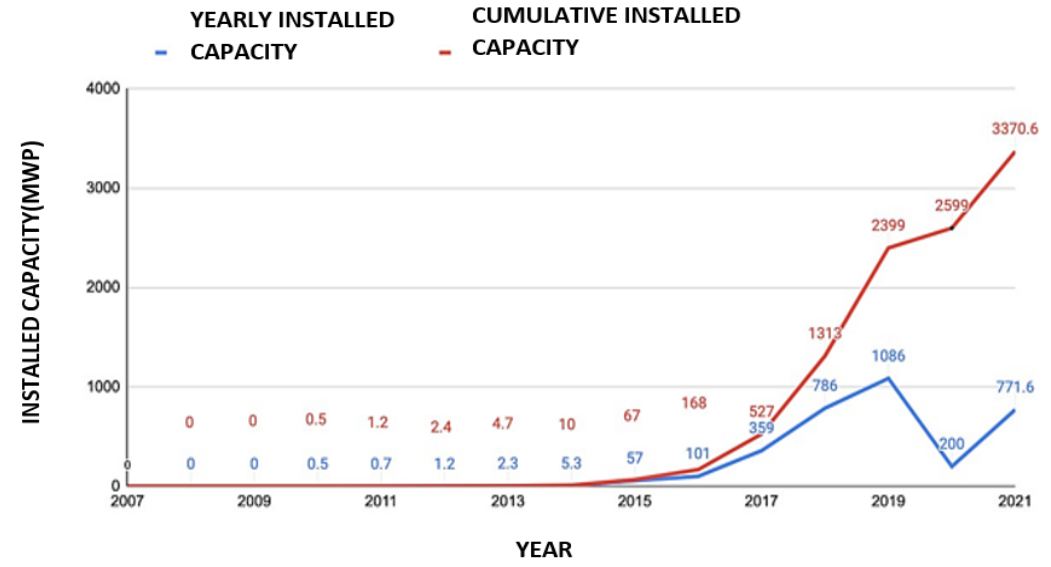
Figure 1. Yearly installed capacity of floating PV plant.